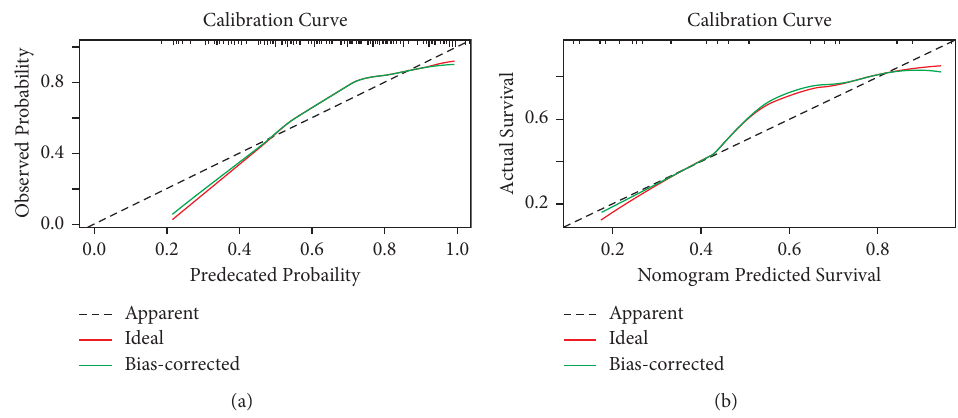
Figure 2: Calibration curves of the nomogram for the training set (a) and the testing set (b).